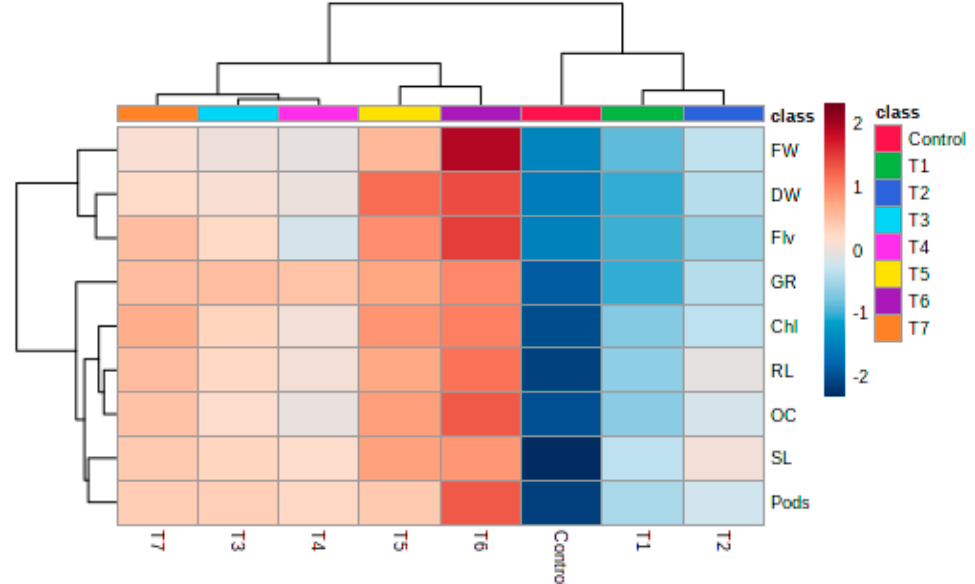
Figure 3. Heatmap generated to determine distance and clustering and showing the effect of biosurfactant and BSP9 on various growth parameters of Indian mustard in a field study (distance measure using Euclidean and clustering algorithm using Ward’s method). T1 to T7 and control are different treatments (T1-0.1% biosurfactant (BS), T2-1.0% B.S, T3-2.0% BS, T4-5.0% BS, T5-1% BS + BSP9, T6-2% BS + BSP9, T7-only BSP9 cells and Control = untreated control). FW-fresh weight, DW-dry weight, Flv-flavonoid content, GR-germination rate, Chl-chlorophyll content, RL-root length, OC-oil content, SL-shoot length, Pods-number of pods.